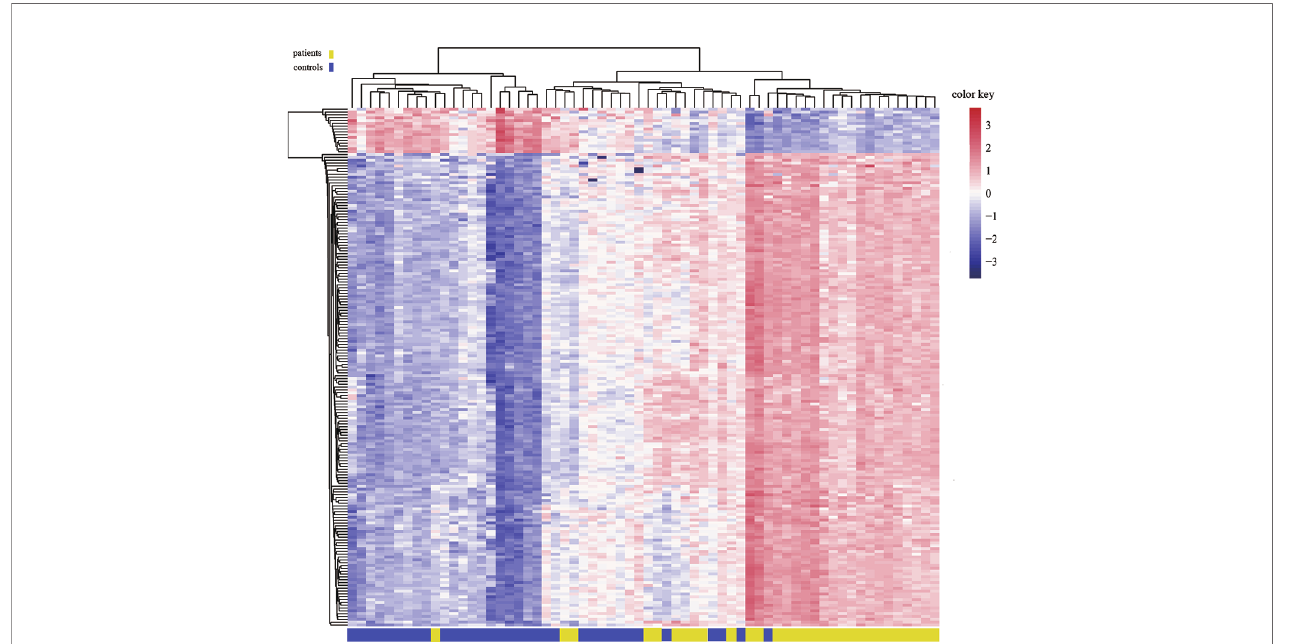
FIGURE 3 | Heat map generated from clustering-analysis of microarray data illustrating differentially methylated DNA sites in blood whole genome in the ICH patient group (n = 30) relative to the control group (n = 34). Blue and red represent levels of hypomethylation and hypermethylation, respectively, whereas white indicates no change in methylation, relative to control.